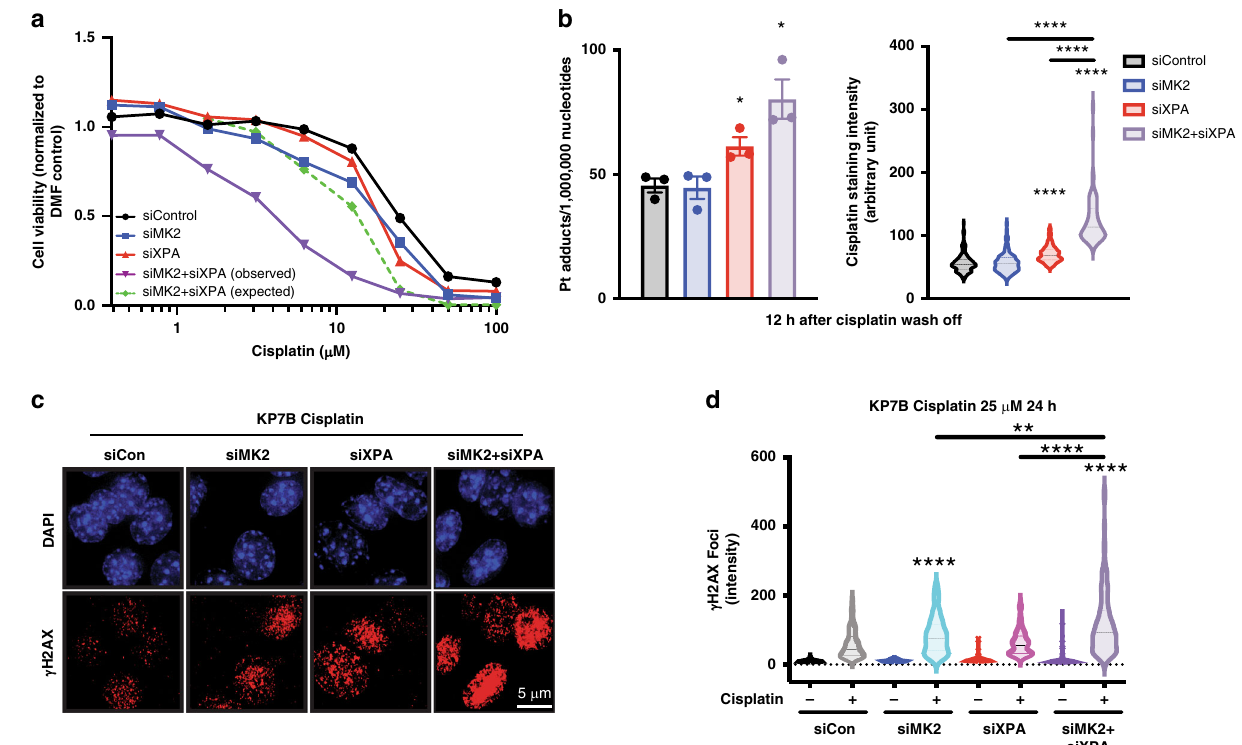
Fig. 2 Co-targeting NER and MK2 enhances cisplatin lethality in cells. a KP7B cells were depleted of MK2, XPA, or both using siRNA, and treated with the indicated concentrations of cisplatin. Cell viability was measured 72 h later using the CellTiter-Glo luminescence assay. The expected viability following combined MK2 and XPA knockdown was calculated assuming a Bliss independence model of additivity (see section “ Methods ” ). b KP7B cells were treated with 25 µ M cisplatin for 5 h. The drug-containing media was then replaced with drug-free media, and DNA repair allowed to occur for 12 h. Residual cisplatin adducts were then quanti fi ed by atomic absorption spectroscopy (left graph; siXPA + cis vs. siCon + cis, * p = 0.0280; siMK2 + siXPA + cis vs. siCon + cis, * p = 0.0144; two-tailed unpaired t test. n = 3 experiments. Error bars represent mean ± SEM) and by immuno fl uorescence using an antibody against cisplatin – DNA adducts (right graph; siXPA + cis vs. siCon + cis, **** p ≤ 0.0001; siMK2 + siXPA + cis vs. siCon + cis, **** p ≤ 0.0001; siMK2 + siXPA + cis vs. siMK2 + cis, **** p ≤ 0.0001; siMK2 + siXPA + cis vs. siXPA + cis, **** p ≤ 0.0001; two-tailed unpaired t test. n = 3 separate samples n > 70 cells per condition). c Representative immuno fl uorescence images of KP7B cells depleted of MK2, XPA, or both proteins treated with 25 μ M cisplatin for 24 h, then fi xed and stained with an antibody against γ H2AX. d Quanti fi cation of the number of γ H2AX foci in the KP7B cells treated as in Fig. 2c for each treatment in n = 3 separate samples. (siMK2 + cis vs siCon + cis, **** p < 0.0001; siMK2 + siXPA + cis vs. siCon + cis, **** p < 0.0001; siMK2 + siXPA + cis vs. siMK2 + cis, ** p ≤ 0.002; siMK2 + siXPA + cis vs. siXPA + cis, ** p < 0.0001; two-tailed unpaired t test. n = 3 separate samples and n > 90 cells per condition). Width in violin plot indicates frequency for each observed value from maximum to minimum, with dotted line indicating